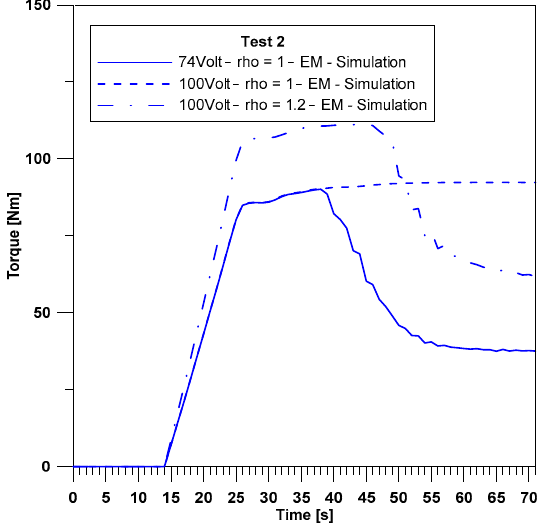
Figure 12. Comparison between calculated torque curves based on test 2 at different EM gear ratio and battery voltage.